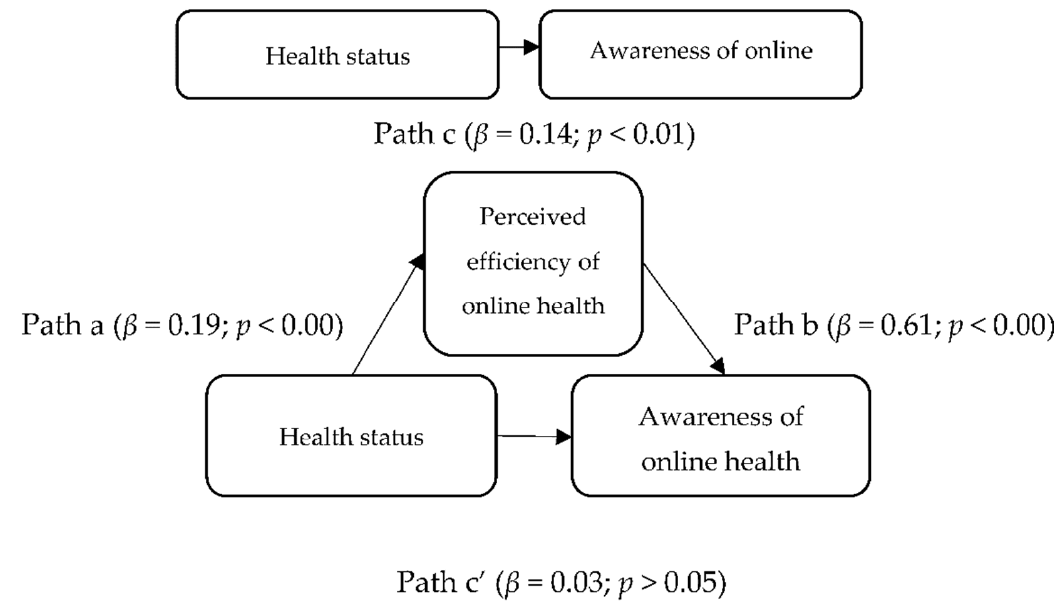
Figure 1. Mediation model.